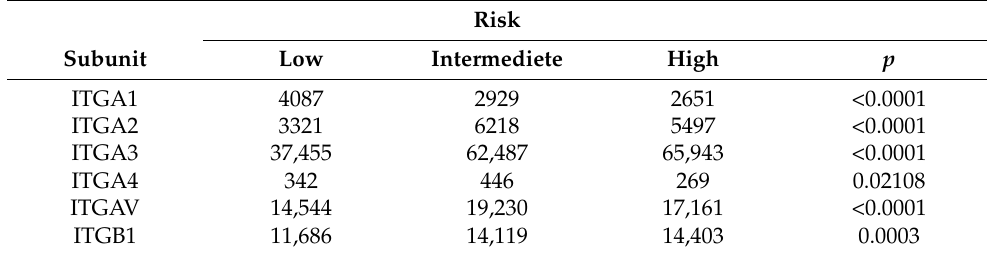
Table 5. Estimated risk of tumor recurrence based on the 2009 American Thyroid Association